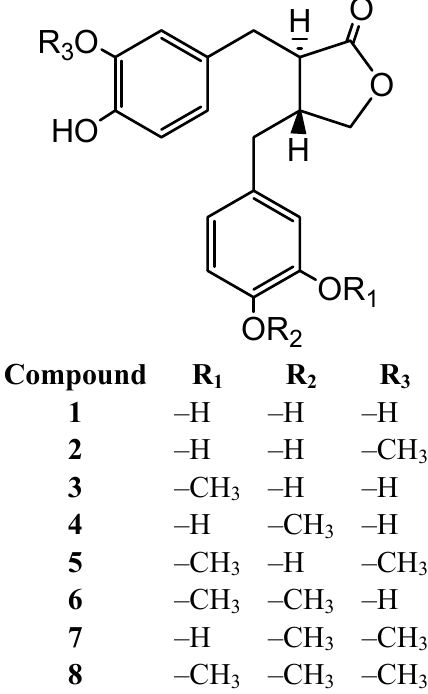
Figure 1. Arctigenin and its metabolites by E. sp.